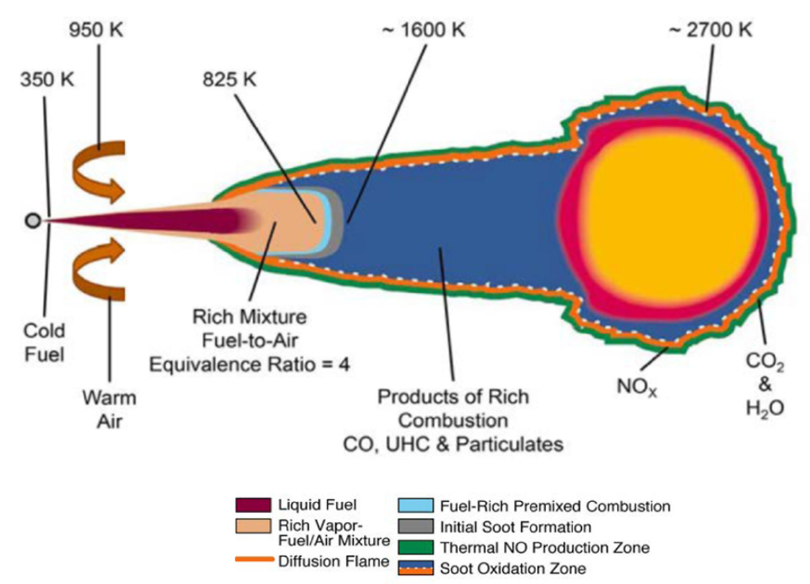
Figure 5. Schematic of a typical stabilized combustion jet in a diesel engine [46].